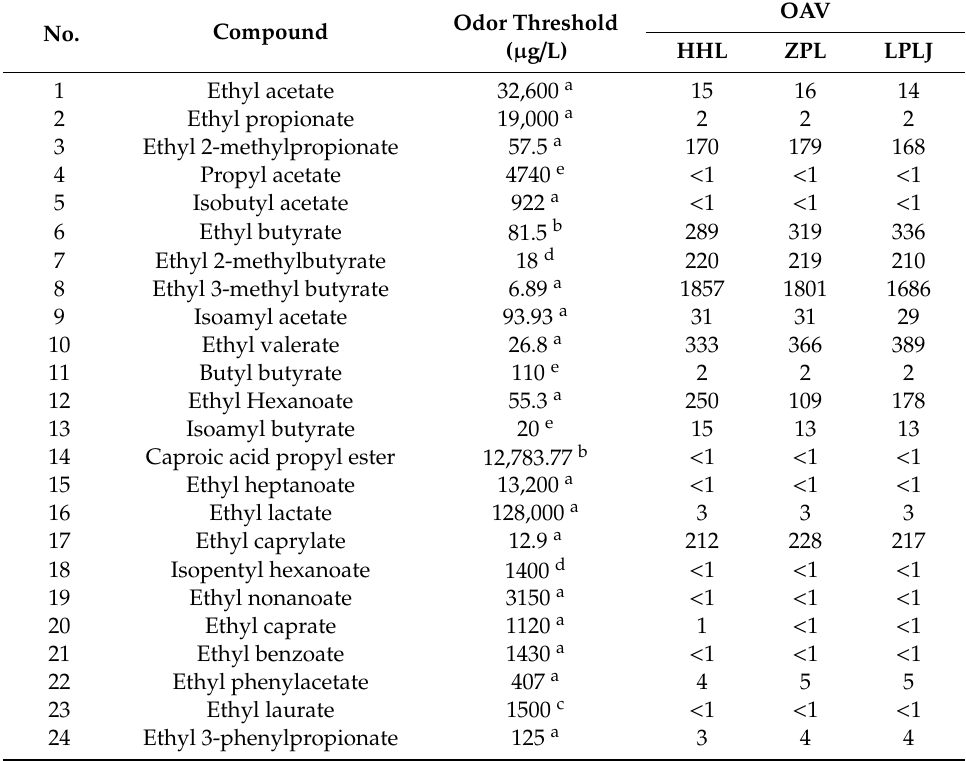
Table 3. Odour activity value (OAV) of the volatile compound in